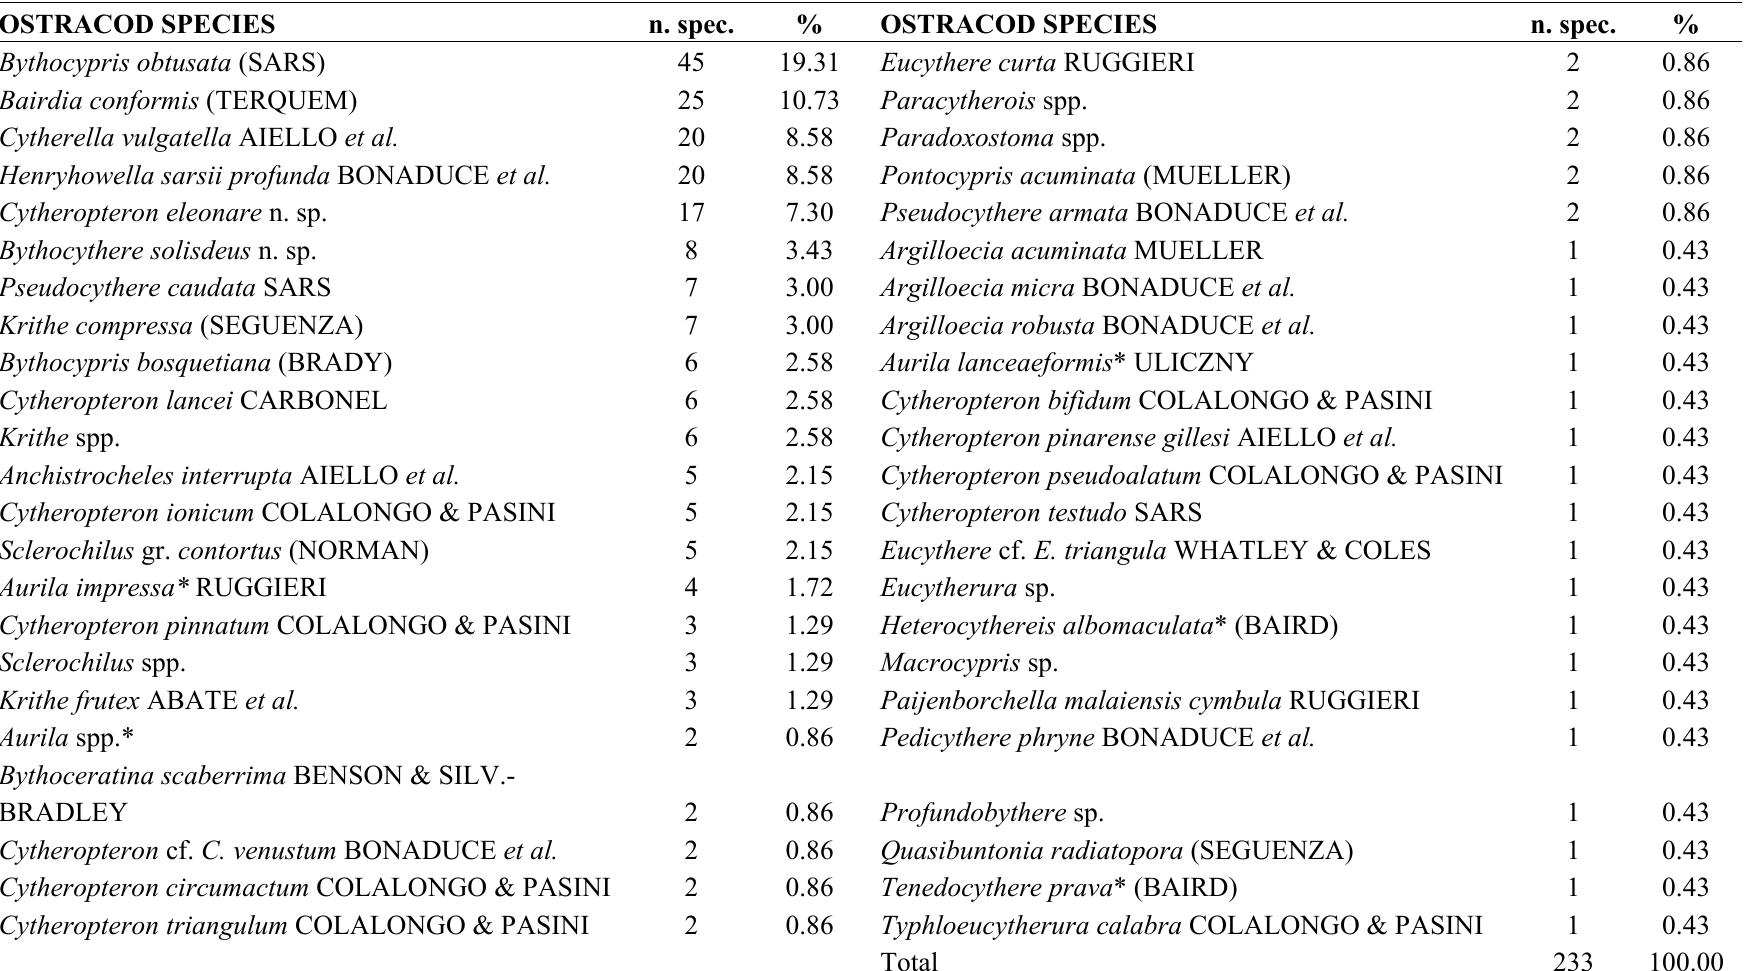
Table 1. List of the ostracod species (in order of abundance) collected in the samples from Cala S. Antonino. OSTRACOD SPECIES n.